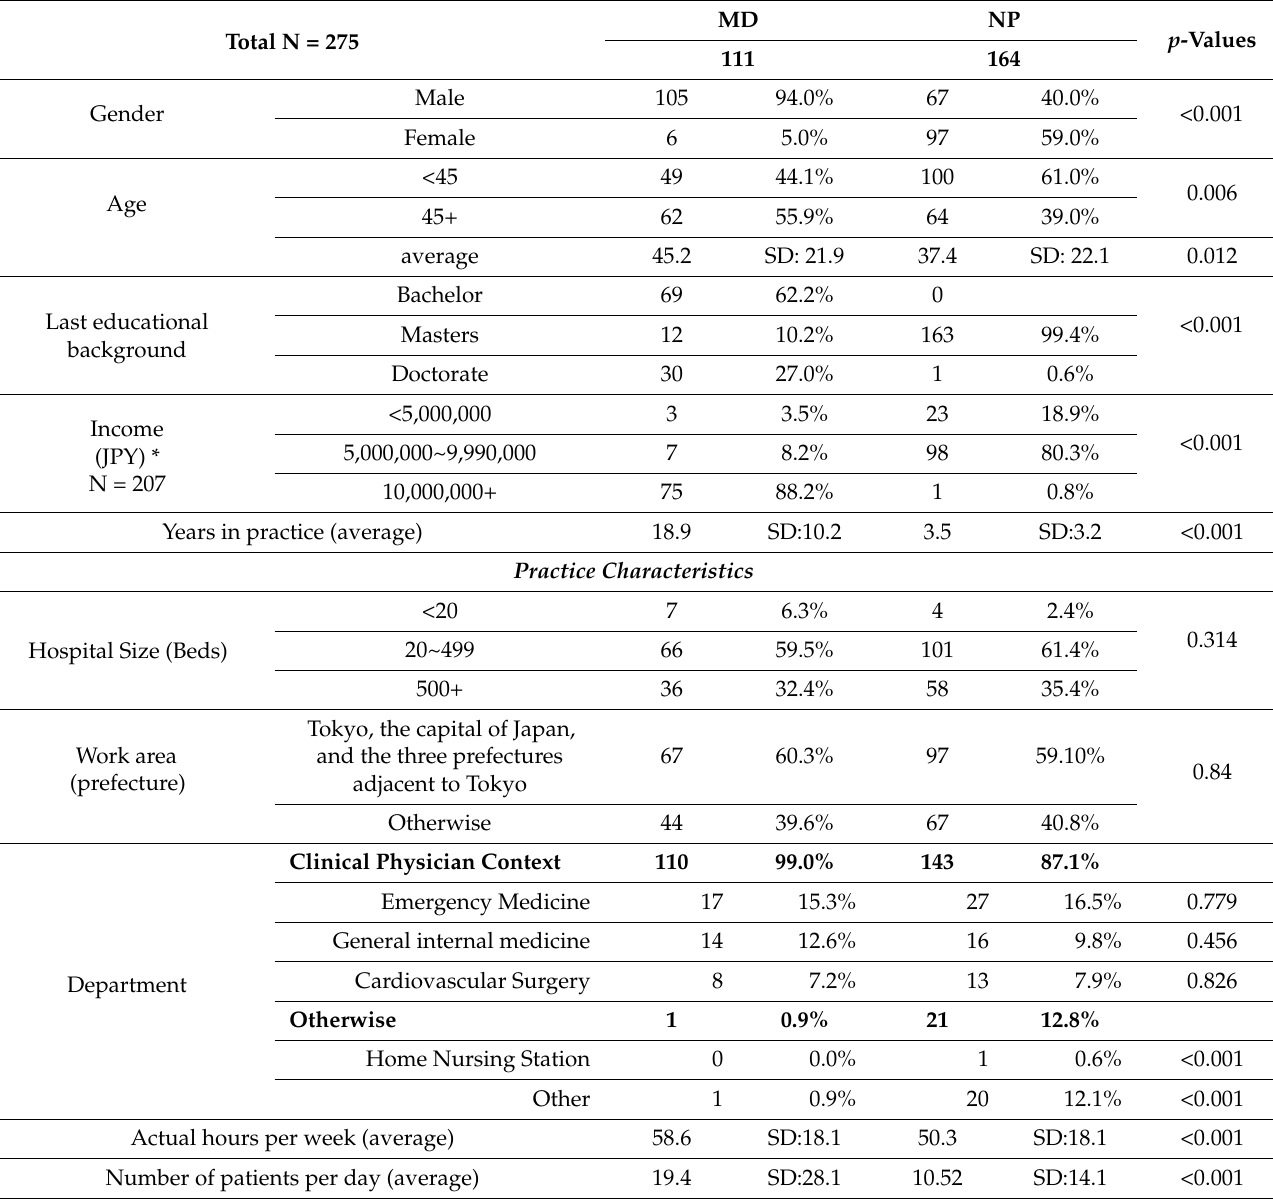
Table 1. Characteristics of